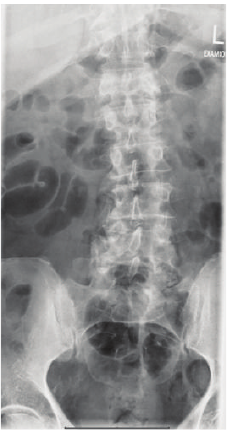
Figure 1: Lumbar spine radiographs on admission showed degen- erative changes.